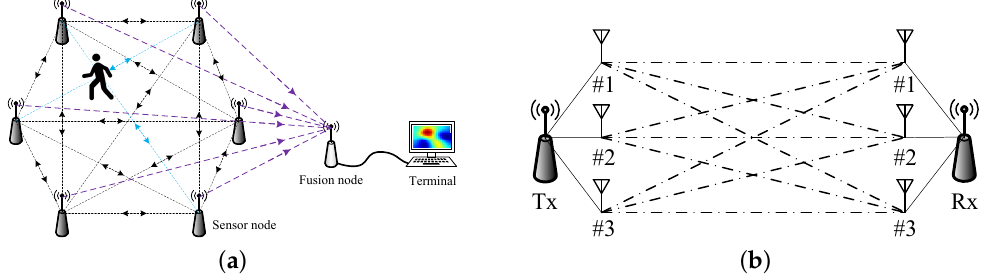
Figure 1. The proposed RTI localization scheme: ( a ) a typical RTI network illustration; ( b ) each wireless link consists of multiple sublinks. In ( a ), the double arrow indicates the bidirectional link and the blue color represents the links obstructed by the target. In ( b ), each node is equipped with three antennae, resulting in a link with nine